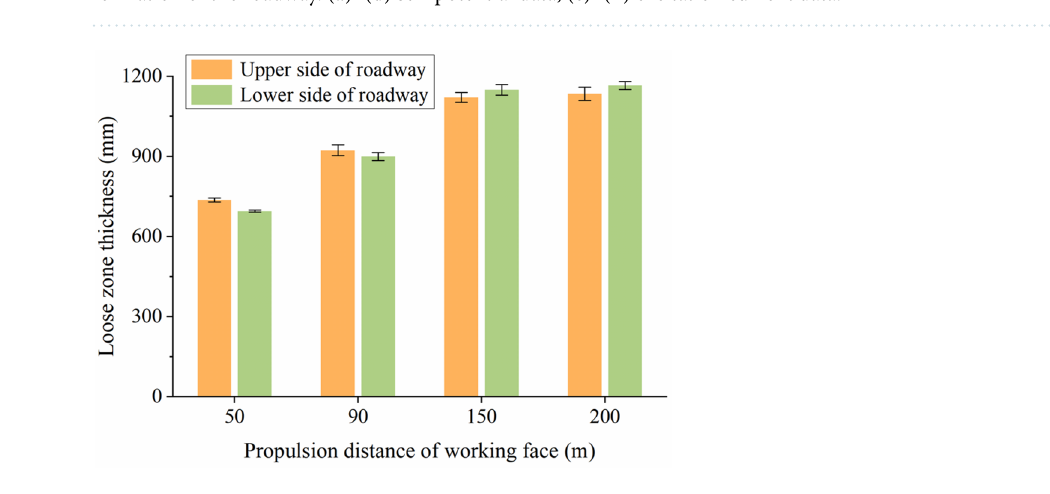
Figure 9. Change in thickness of the loose roadway-surrounding rock zone near the monitored